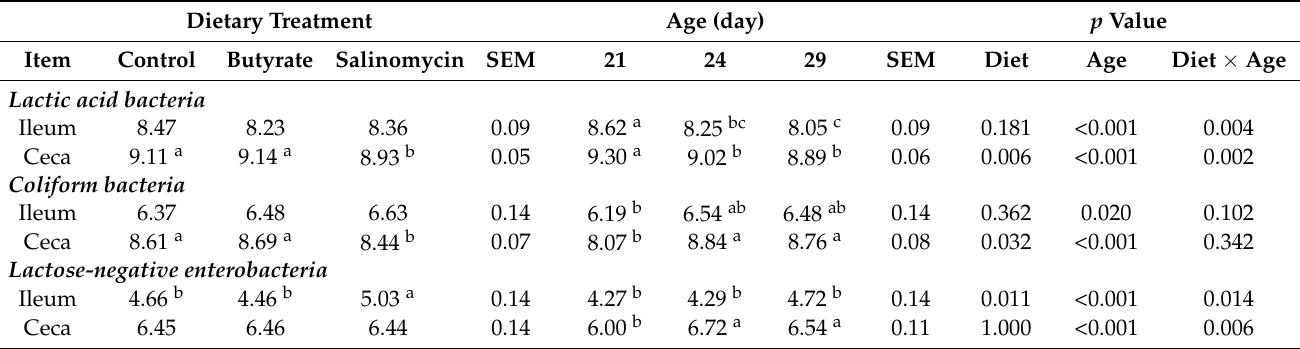
Table 2. Bacterial counts (log CFU/g digesta) in the ileum and ceca of broilers at different ages, fed a diet containing salinomycin, coated butyrate, or no dietary supplement (control) 1